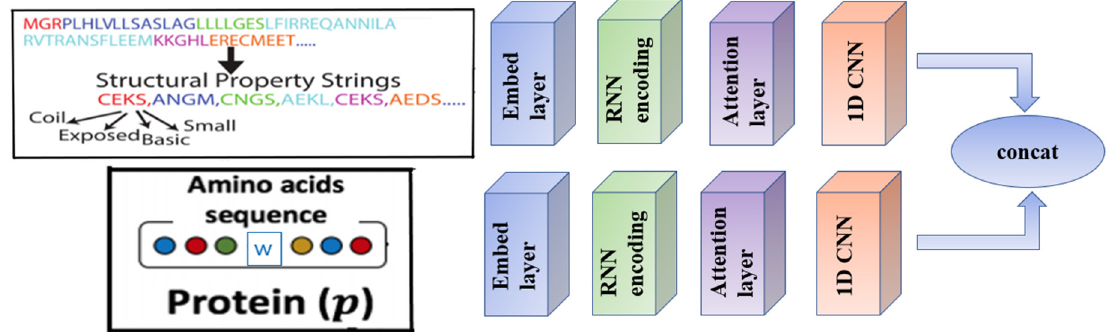
Figure 6. Network diagram of the protein feature vectors extraction.